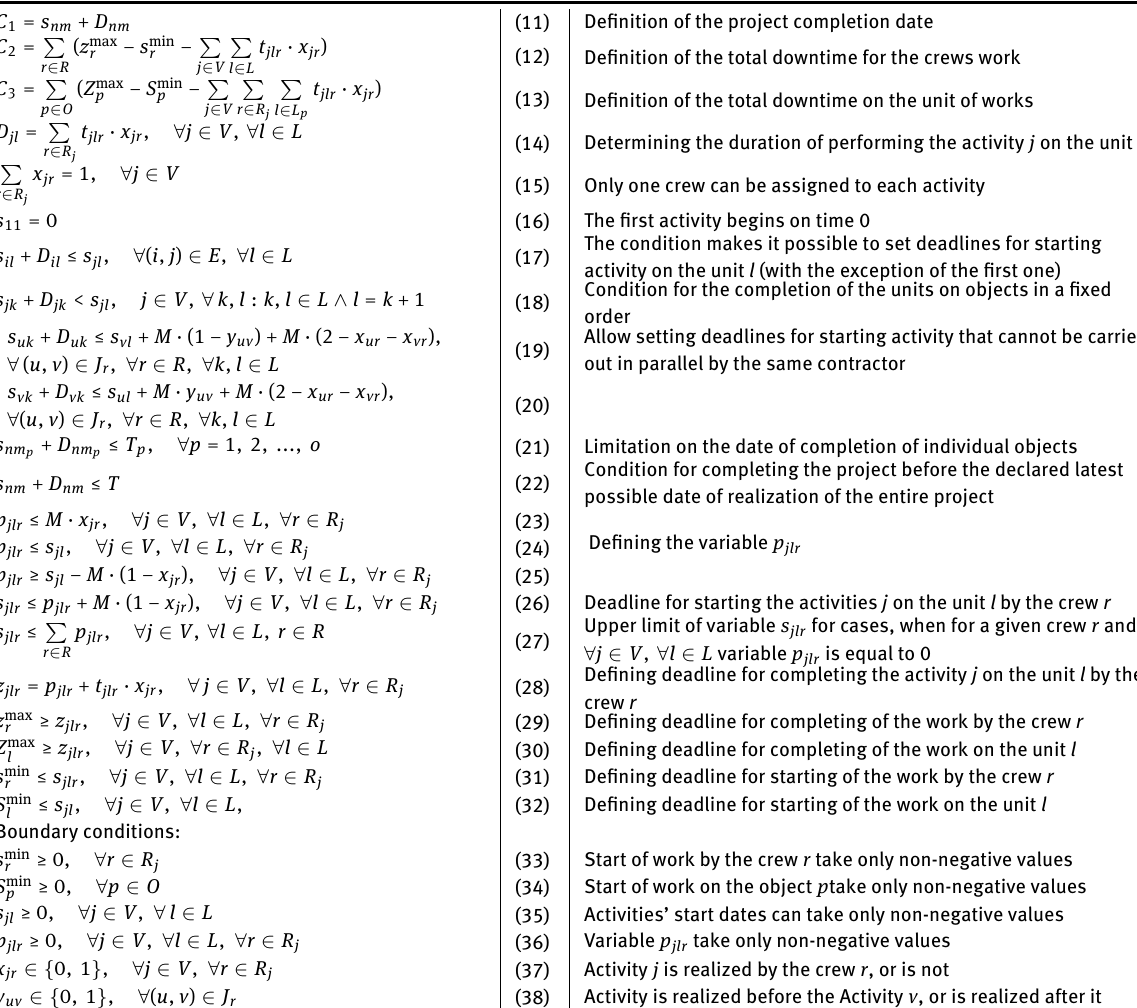
Table 2: Constraints of the mathematical model.